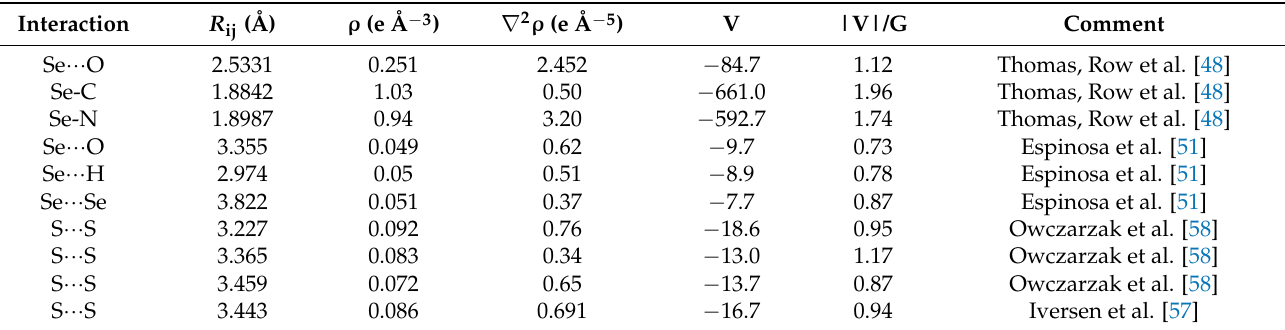
Table 3. Topological parameters for noncovalent chalcogen